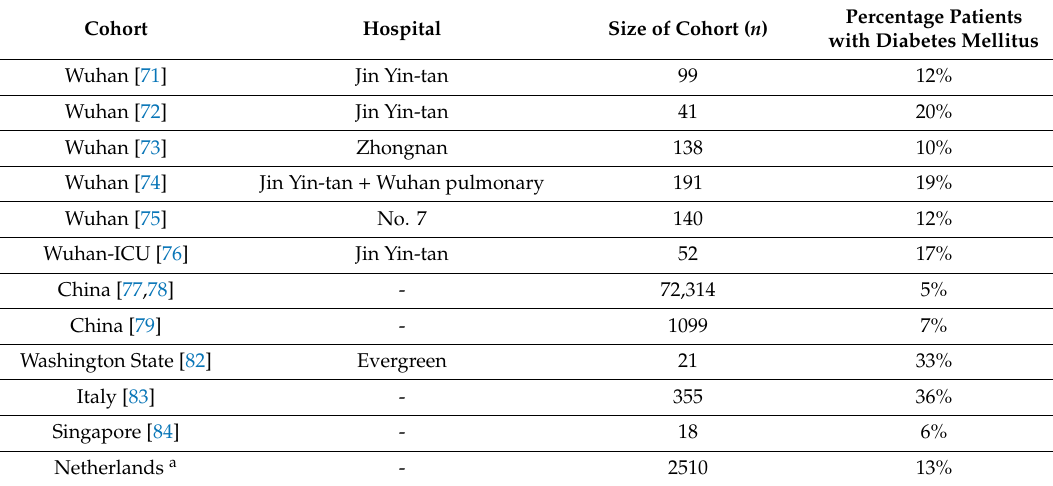
Table 3. Cohorts including data on diabetes mellitus in the current